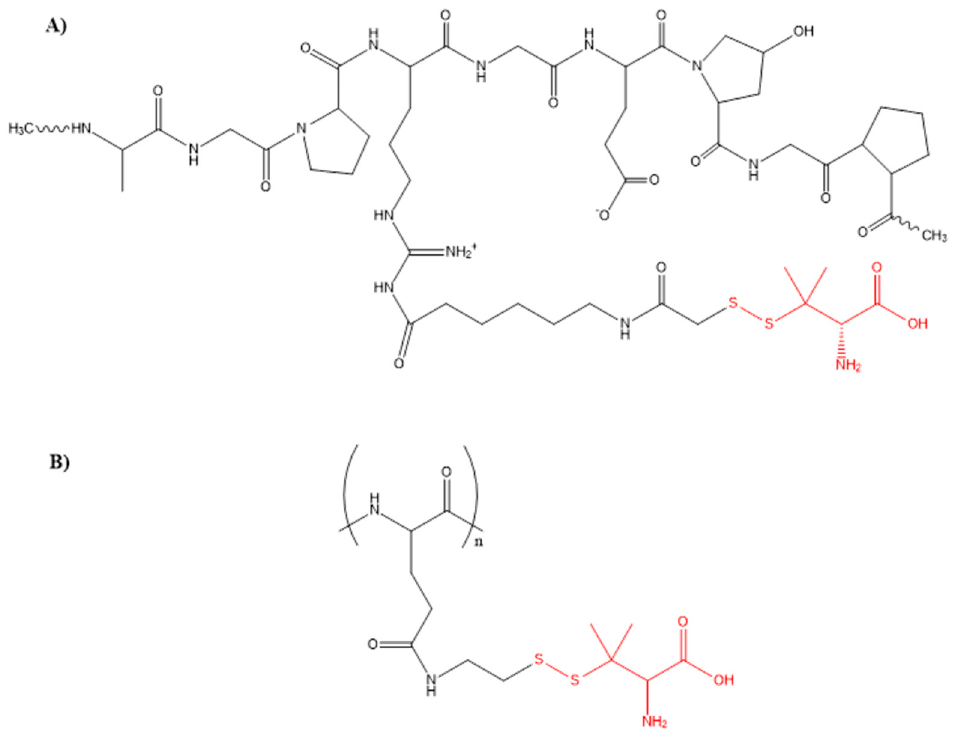
Figure 4. Proposed D-pen conjugates as drug delivery systems for D-pen. ( A ) Gelatin-D-pen conjugate. ( B ) Poly- L -glutamic acid (PGA)-D-pen conjugate. Reprinted with permission from Bioconjugate Chemistry , 19 , 1382–1388. Copyright 2008 American Chemical Society [53].